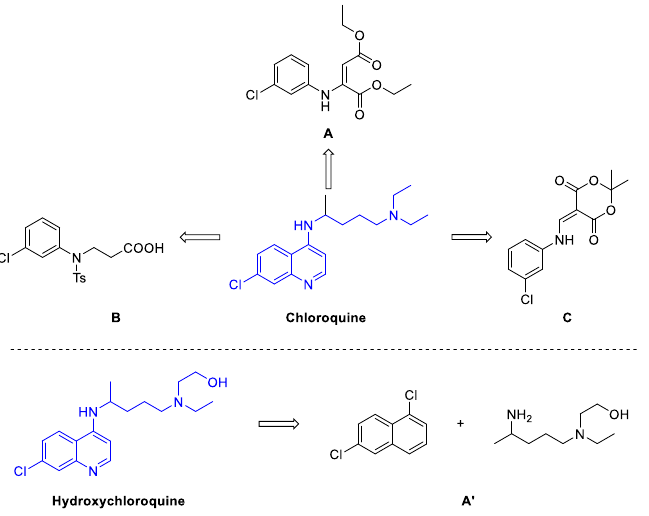
Figure 2. Key intermediates in chloroquine synthesis as reported by Hammer ( A ), Jonnson ( B ), and Margolis ( C ). The lower panel shows a common retrosynthetic approach for hydroxychloroquine synthesis as reported by Hammer, Kumar, Min, and Yu.